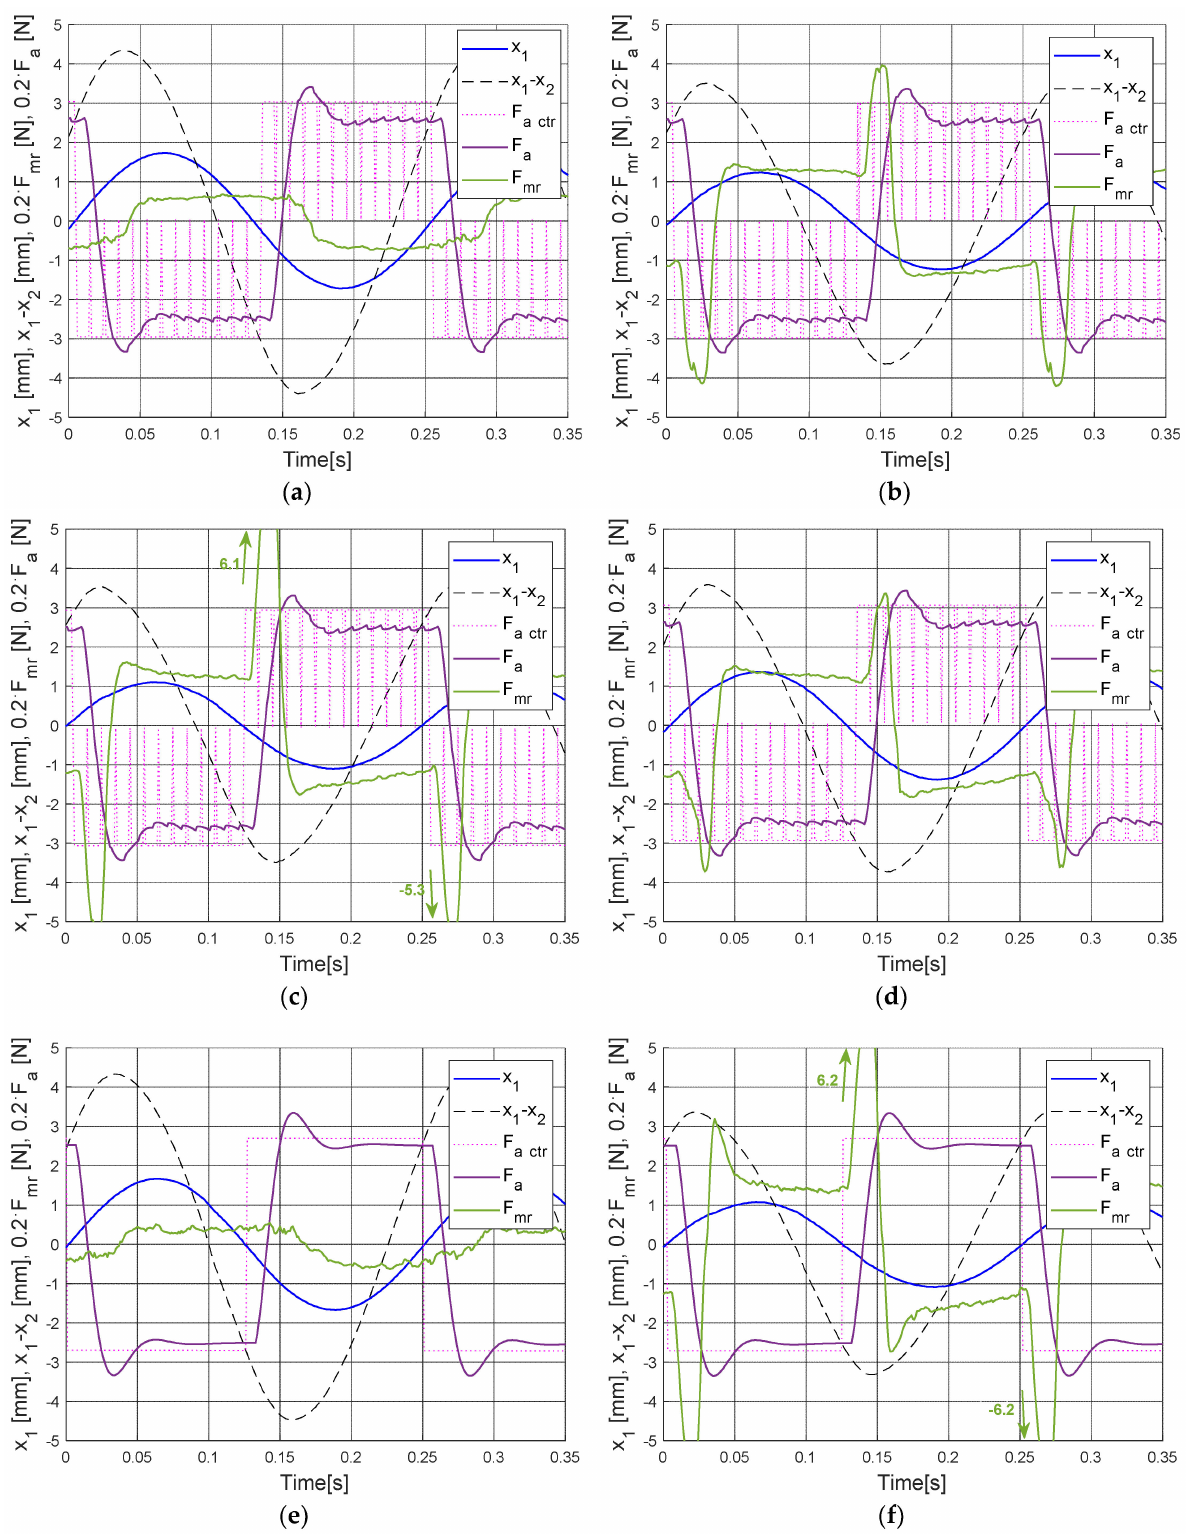
Figure 19. Time responses at 4.0 Hz: ( a ) OPT , i max = 0 ( b ) OPT , i max = 0.5 A ( c ) OPT , i max = 1.0 A, ( d ) OPT , i max = 1.0 A, g 221 = 10 6 , ( e ) GH , i max = 0, ( f ) GH , i max = 1.0 A ( F nom = 12.5